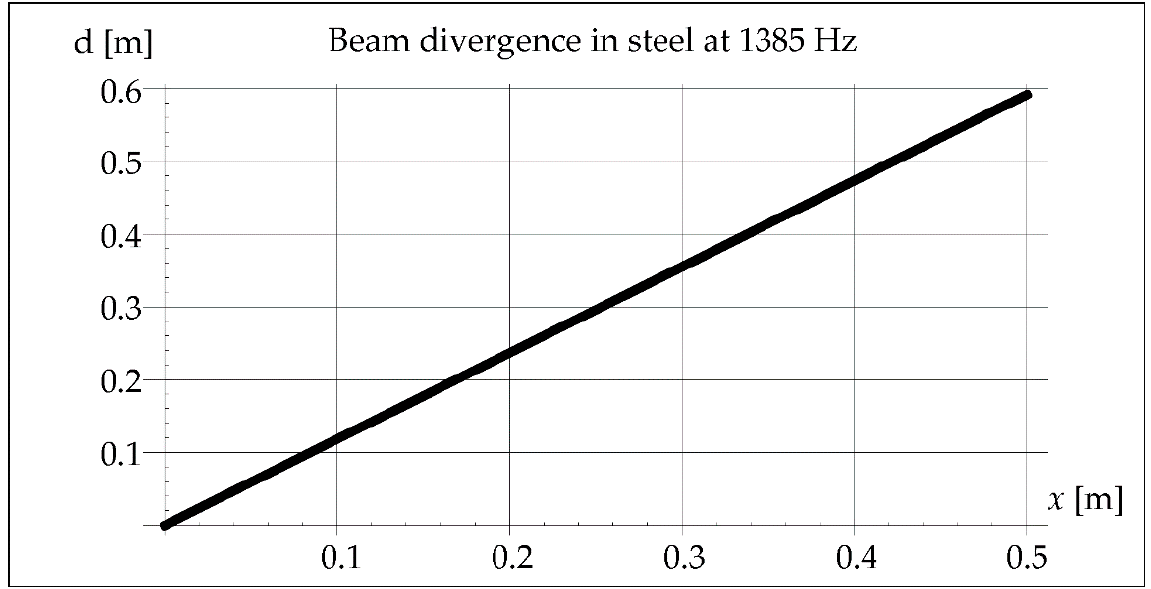
Figure 18. Beam divergence in steel at 1385 Hz.